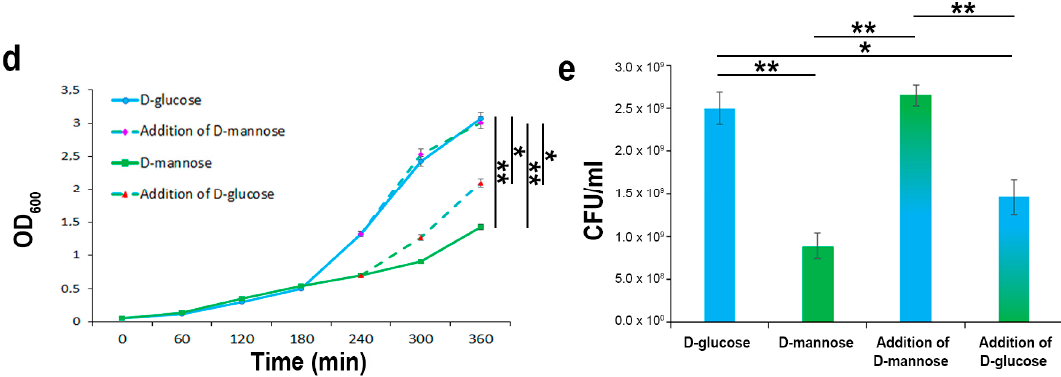
Figure 2. E. coli growth kinetics and ATP yields using different carbon sources. Strain CFT073 was grown on an M9 medium supplemented with the indicated sugars at a final concentration of 0.5% for 4 h. Growth curves were followed by OD 600 measurements ( a ), while CFU / mL counting ( b ) and ATP intracellular content were assessed at endpoint ( c ). Strain CFT073 was grown on M9 medium supplemented with 0.5% d -glucose or 0.5% d -mannose. After 4 h, 0.5% of d -mannose or 0.5% d -glucose were added to the d -glucose or d -mannose-supplemented bacterial cultures, respectively, and the growth rates were recorded for a further 2 h by OD 600 measurements ( d ) and CFU / mL counting at endpoint ( e ). Data represent the mean of three independent experiments. Asterisks indicate p values evaluated by one-way ANOVA; ** p ≤ 0.01, * p ≤ 0.05.